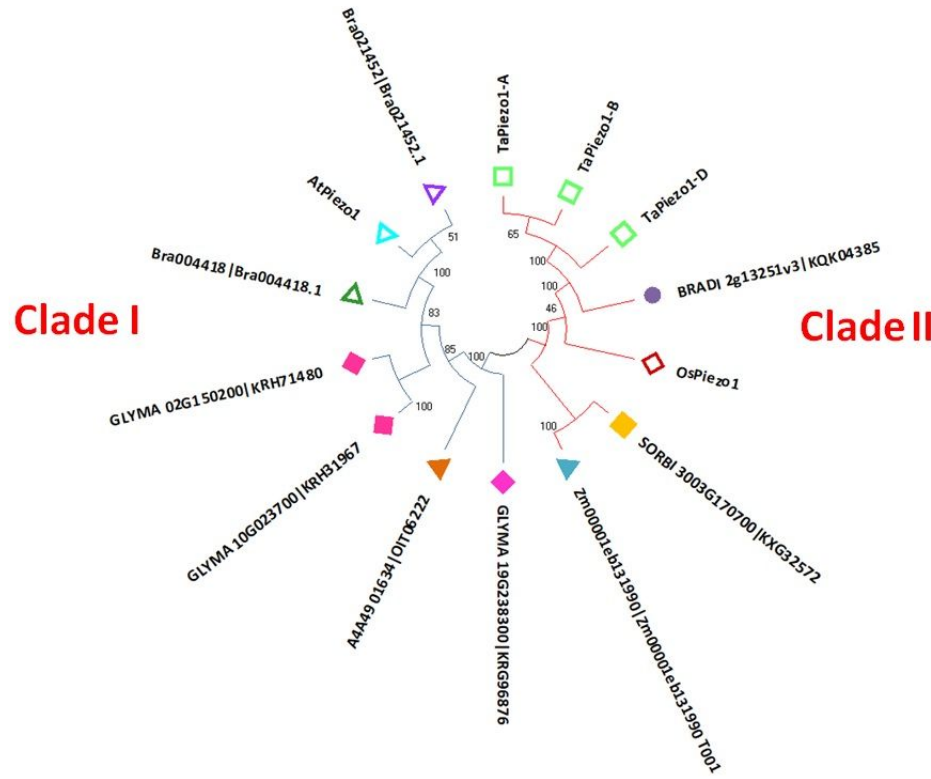
attenuate (A4A49_01634|OIT06222), S. bicolor (SORBI_3003G170700|KXG32572 ) , and Z. mays (Zm00001eb131990|Zm00001eb131990_T001). The phylogenetic tree represents the clustering of Piezo proteins into two clades, and each clade is colored differently.